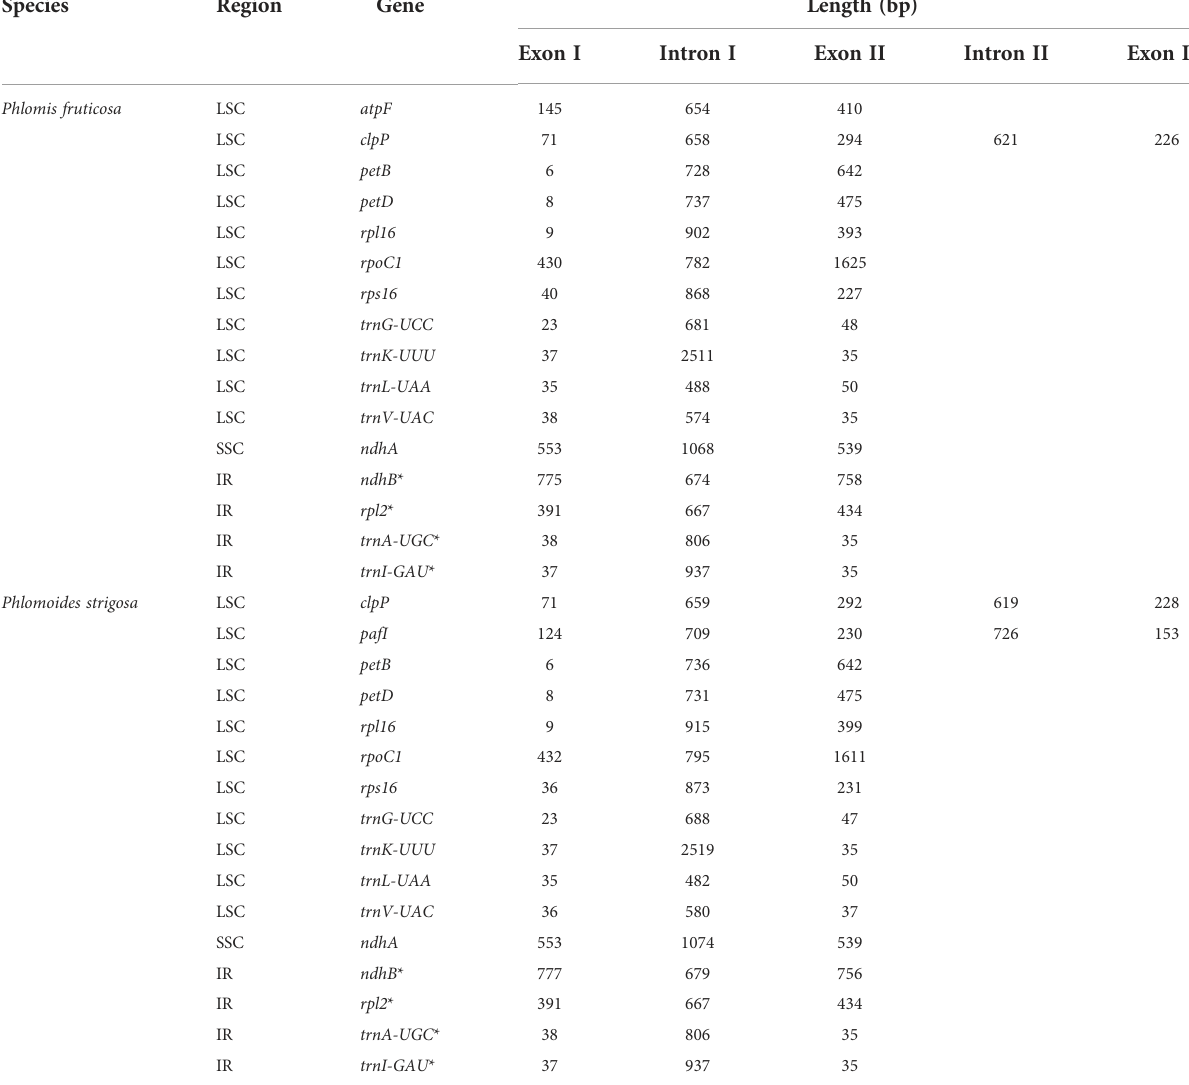
TABLE 3 Intron-containing genes and the length of exons and introns. Species Region Gene